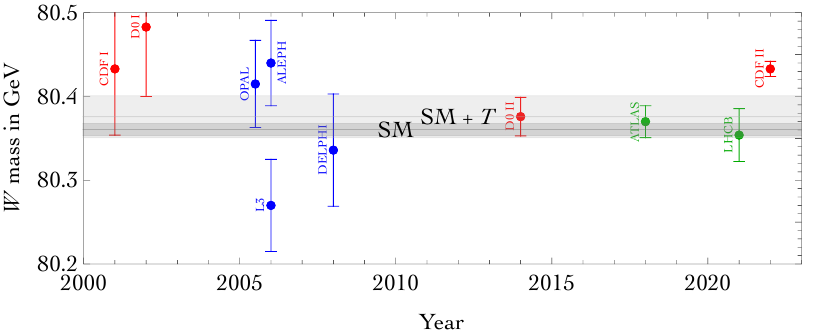
Figure 1. Measurements of the W -boson mass compared to the ± 1 σ band predicted by the SM (darker thinner band) and by the SM extended allowing for a free T parameter (lighter wider band and eq.